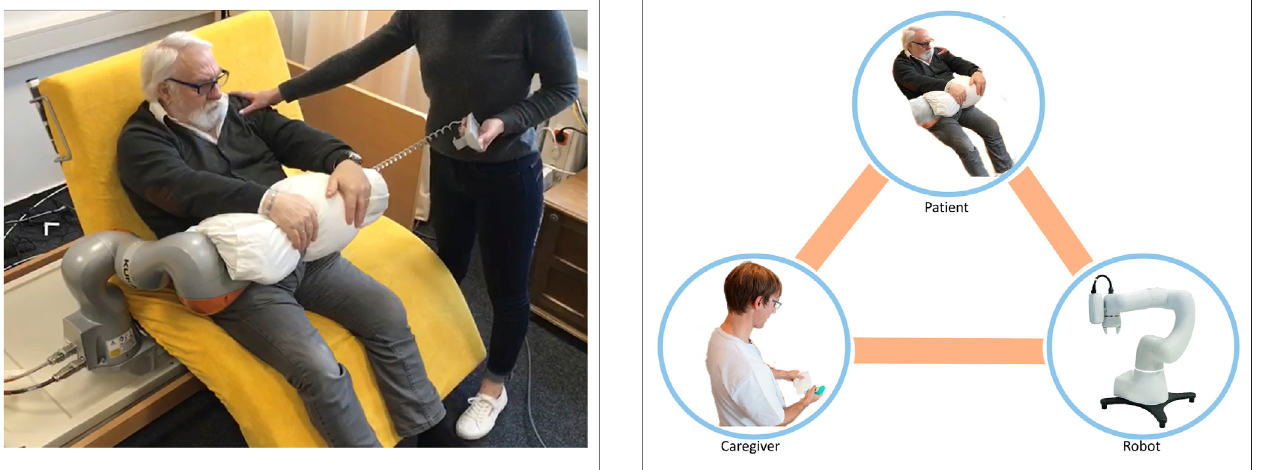
Frontiers in Robotics and AI |